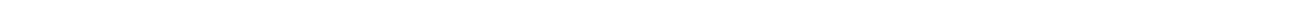
Figure 2 | Nuclear AURKA activates MYC transcription and induces a shift in MYC promoter usage. ( a ) DBD/AURKA-DBD, DBD-reporter and pRL-TK were co-transfected into 293T for 24h. Immunoblotting (IB; left panel) and dual-luciferase reporter (right panel) analysis were performed. ( b ) DBD/AURKA-DBD, DBD-reporter and pRL-TK were co-transfected into 293Tcells. After 12h, cells were treated with VX-680, MLN8237 or Aurora-A inhibitor I for 12h. IB (left panel) and dual-luciferase reporter assay (right panel) were performed. ( c ) Diagram showing potential TADs in AURKA. ( d ) DBD/AURKA-DBD, DBD-reporter and pRL-TK were co-transfected into 293T cells for 24h. IB (left panel) and dual-luciferase reporter assay (right panel) were performed. ( e ) STRING analysis showing connections among AURKA-regulated genes. ( f ) ER/AER, MYC promoter/basic reporter and pRL-TK were co-transfected into MDA-MB-231 cells. After 6h, AURKA nuclear translocation was induced by treating cells with 200nM OHT for 18h. Dual-luciferase reporter assay was performed. ( g ) Treatment was the same as in f . Expression of indicated genes was determined via real-time PCR and IB analysis. ( h ) Treatment was similar to d , except for using MYC promoter reporter instead of DBD reporter. IB (left panel) and a dual-luciferase reporter (right panel) analysis were performed. ( i ) AURKA or empty vector was co-transfected into MDA-MB-231 cells with truncated MYC promoter (MYC) or basic reporter (Vec) along with pRL-TK. After 24h, dual-luciferase reporter assays were performed. ( j ) MDA-MB-231 cells were subjected for ChIP analysis of MYC promoter occupancy. Results were normalized with the input. ( k ) VX-680-treated MDA-MB-231 cells (48h) were subjected for ChIP analysis of MYC promoter occupancy. ( l ) Cells were cultured in suspended or adherent condition with same medium for 7 days. S1 nuclease protection assay (SNPA) was performed to examine MYC P1 and P2 transcripts. Control gene, b -2-microglobulin (B2M) , mRNA in parallel identical samples were also determined. ( m ) BCSC and non-BCSC populations were isolated according to CD24 expression. SNPA was performed. ( n ) ER/AER plasmids were transfected into 293T cells. After 6h, AURKA nuclear translocation was induced by treating cells with 200nM OHT for 18h. SNPA was performed. ( o ) DBD/AURKA-DBD were transfected into 293T cells for 24h. SNPA was performed. Bars represent the means ± s.e.m. of three independent experiments (analysis of variance (ANOVA) followed by least significant difference (LSD) test; * P o 0.05, ** P o 0.01, *** P o